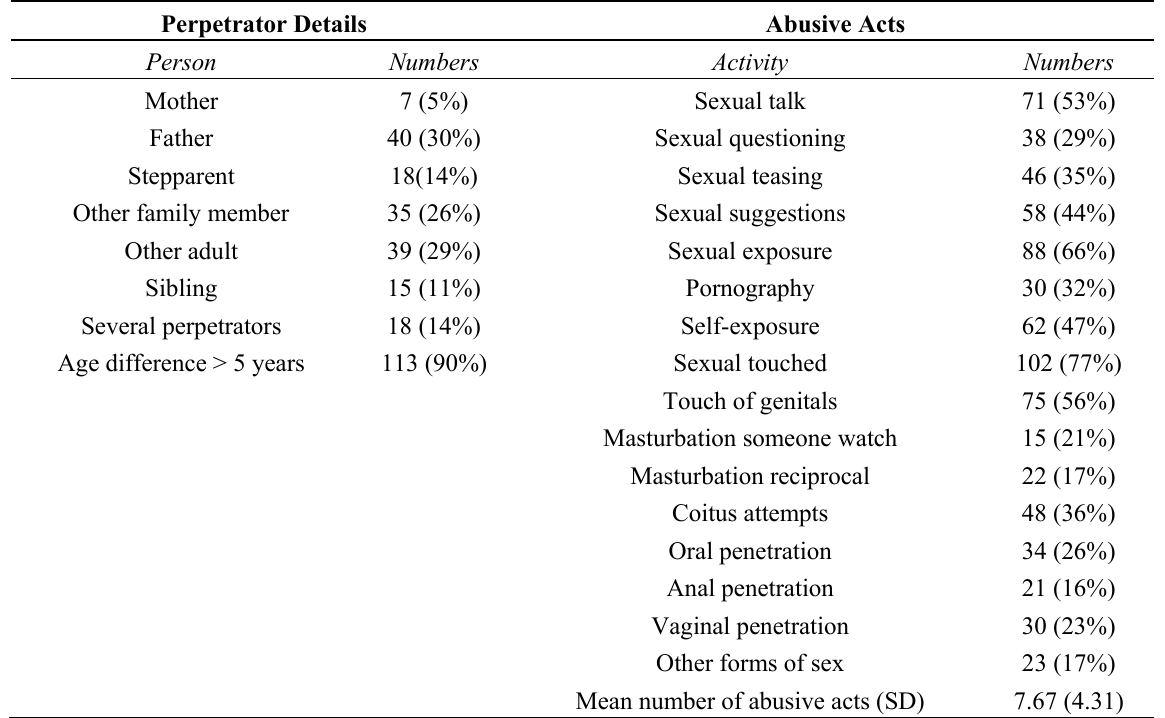
Table 1. Perpetrator and abusive acts, count and